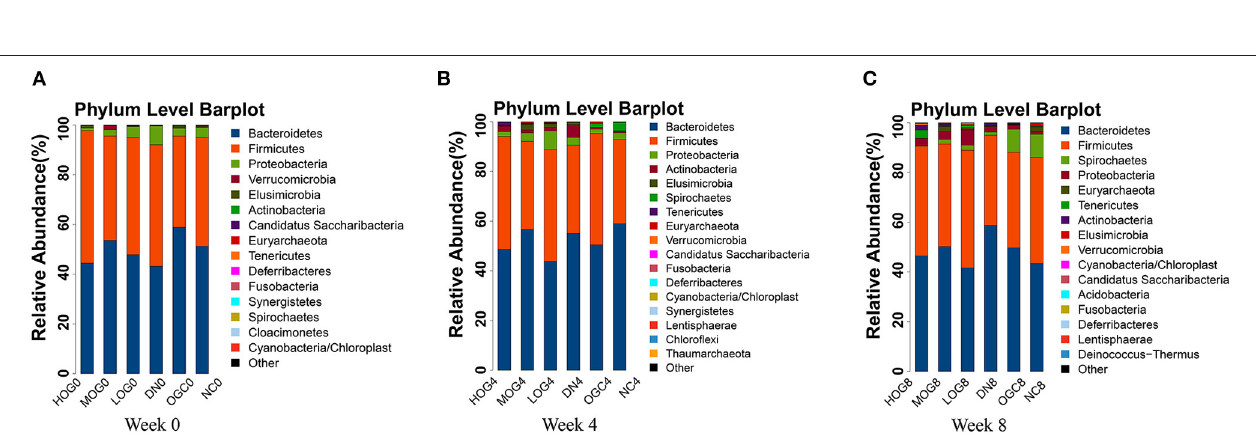
FIGURE 6 | Gut microbial alterations at phylum level of the rats in each group at 0 (A) , 4 (B) , and 8 (C) weeks. Bar plots reflect average relative abundance profiles at phylum level.